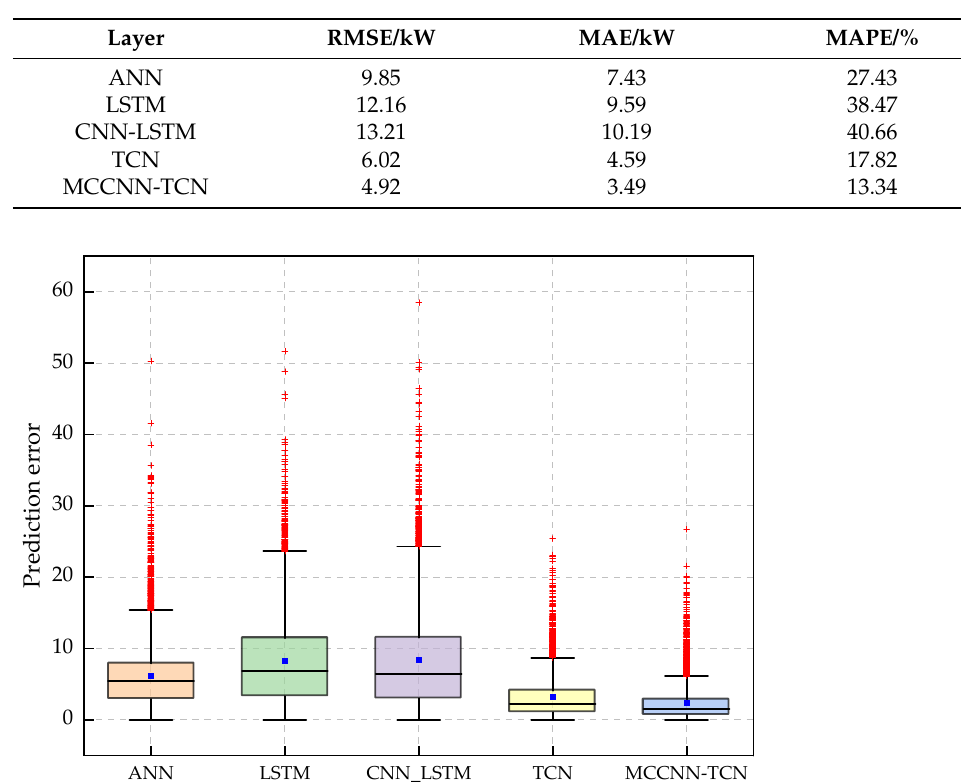
Table 13. Comparison of forecasting errors of models in each season.